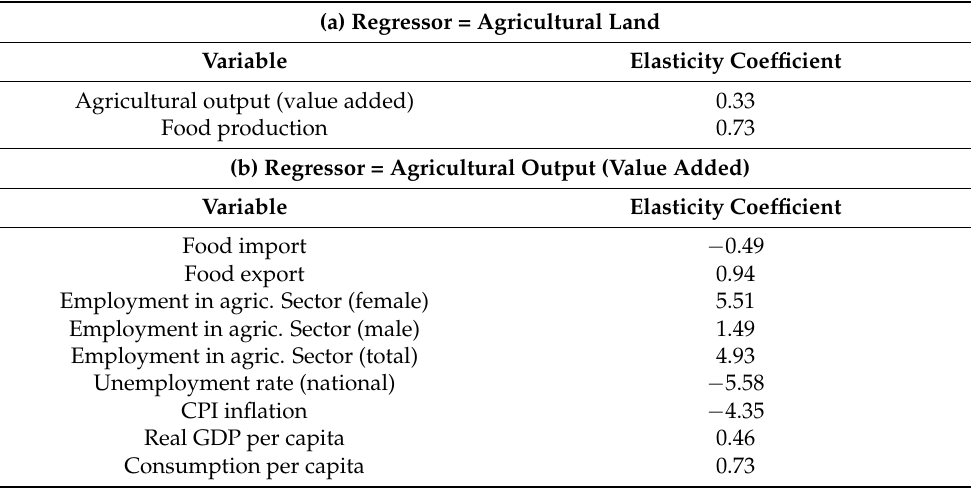
Table 3. Elasticity coefficients for selected variables grouped by